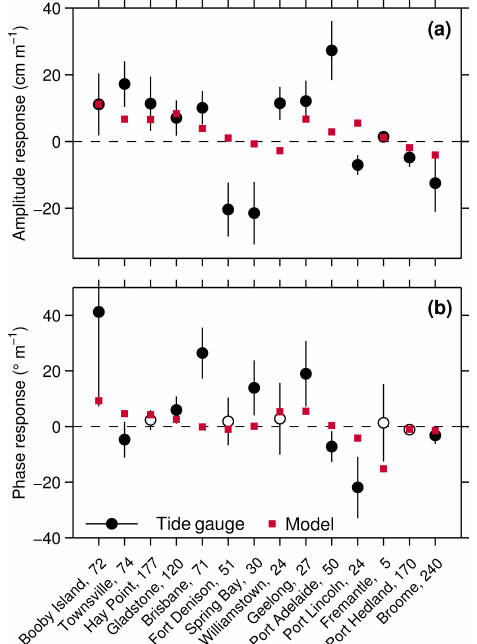
Figure 3. Observed and modelled M 2 response coefficients in (a) amplitude H and (b) phase lag G per metre of SLR. Model val- ues (red squares) are based on the 1m FL simulations, while tide gauge estimates at 14 out of 24 locations are shown in black. Error bars correspond to 2 standard deviations, propagated from the trend analyses of sea-level and annual tidal estimates of M 2 . Stations with insignificant phase trends (at the 95% confidence level) are shown as white markers in panel (b) . Numbers at the end of the station labelling indicate mean observed M 2 amplitudes